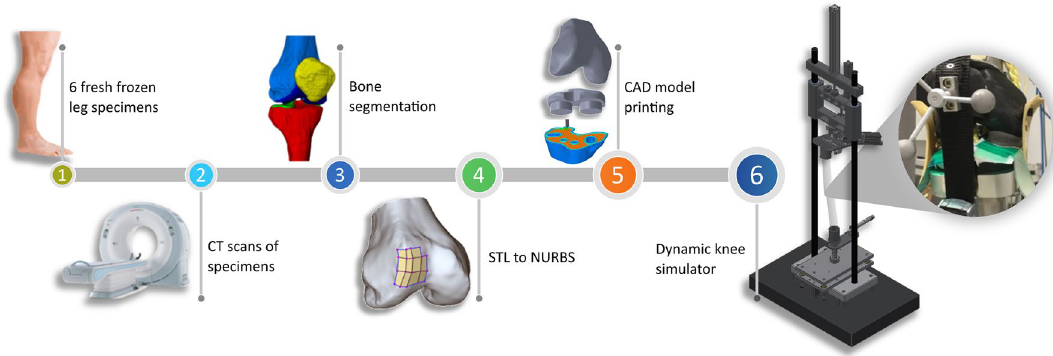
Figure 1. Depiction of the methodological workflow. After scanning every leg specimen (1,2), the different knees were geometrically segmented (3) to further process the data (4) towards printing the articulating knee parts (5) and implement them into the dynamic knee loading simulator (6) ( CT computed tomography, STL standard triangle language, NURBS non-uniform rational B-spline, CAD computer aided